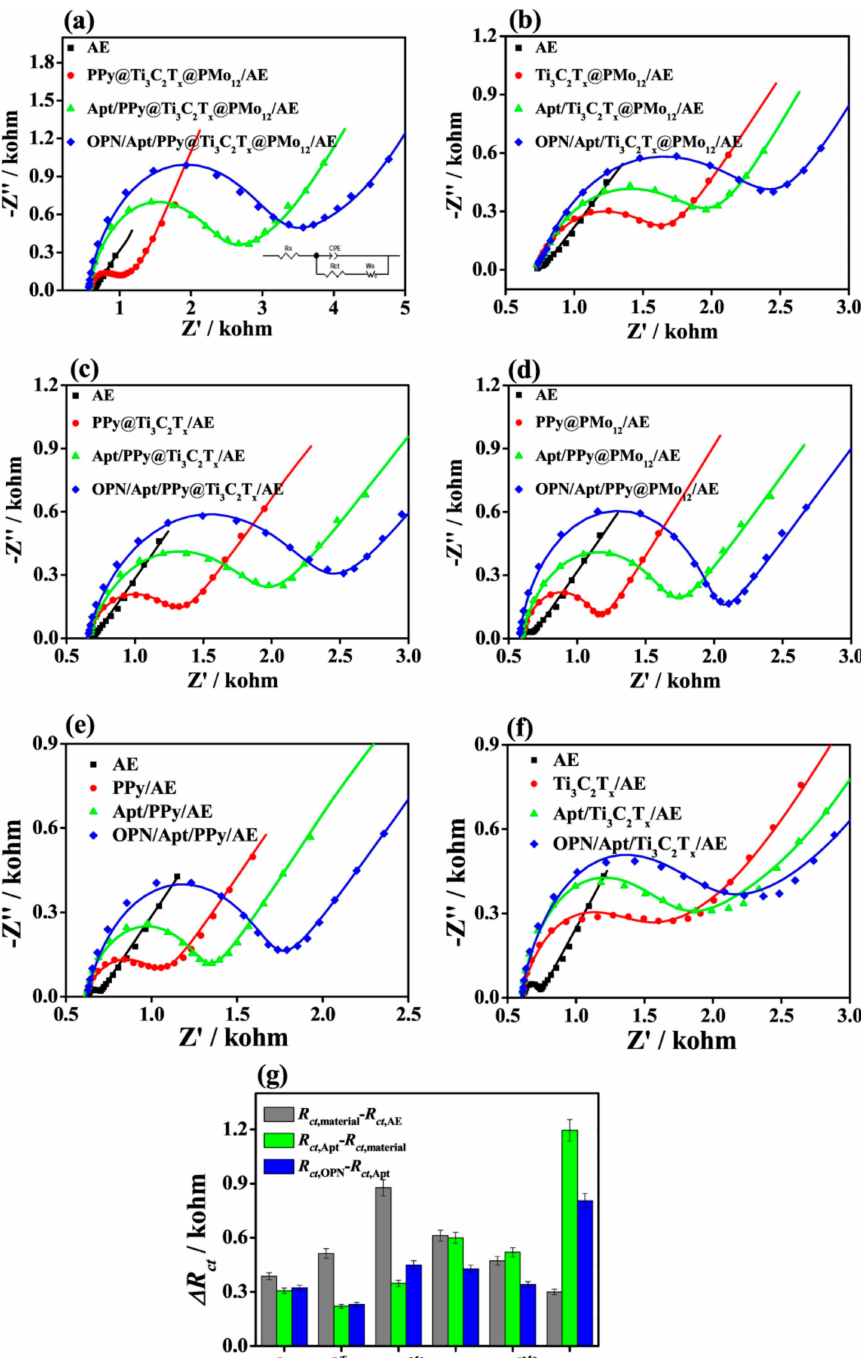
Figure 10. Nyquist plots for ( a ) PPy@Ti 3 C 2 T x / PMo 12 -, ( b ) Ti 3 C 2 T x @PMo 12 -, ( c ) PPy@Ti 3 C 2 T x -, ( d ) PPy@PMo 12 -, ( e ) PPy-, and ( f ) Ti 3 C 2 T x -based aptasensors and ( g ) their corresponding variations in ∆ R ct values at each stage for the OPN detection using the fabricated aptasensors based on PPy, Ti 3 C 2 T x , Ti 3 C 2 T x @PMO 12 , PPy@Ti 3 C 2 T x , PPy@PMo 12, and PPy@Ti 3 C 2 T x / PMo 12 nanohybrids. PPy stands for polypyrrole; PMo 12 stands for phosphomolybdic acid nanoparticles and OPN stands for osteopontin. Reprinted from ref. [66], Copyright (2019), with permission from